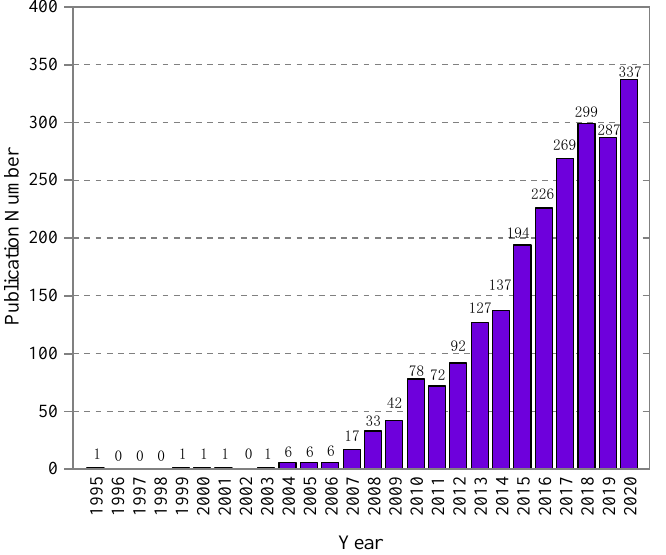
Figure 1. Distribution of publications per year on MFCs in wastewater treatment from 1995 to 2020.